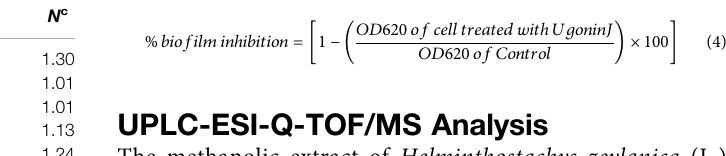
TABLE 2 | Fluorescence quenching effects of compounds 1 – 6 on BNA.